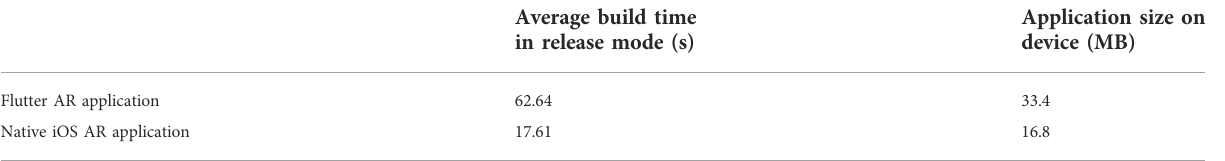
TABLE 4 Average build times and resulting application sizes of the benchmarking applications on an iOS device.